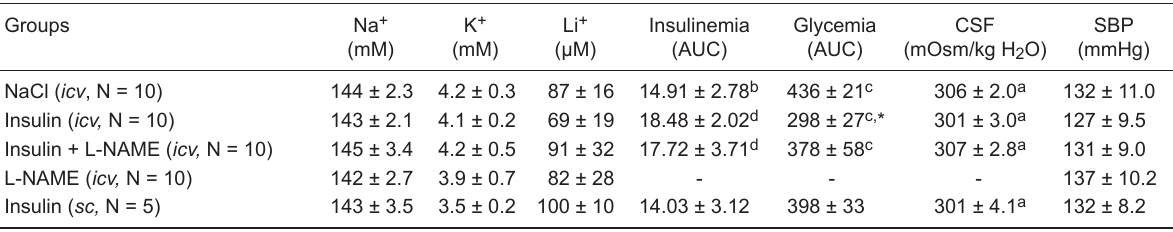
Table 1. Effect of lateral intracerebroventricular ( icv ) or subcutaneous ( sc ) microinjection of 126 ng/3 µL insulin on cerebrospinal fluid osmolarity, serum sodium, potassium and lithium levels, and insulinemia, glycemia and systolic blood pressure (SBP) compared to